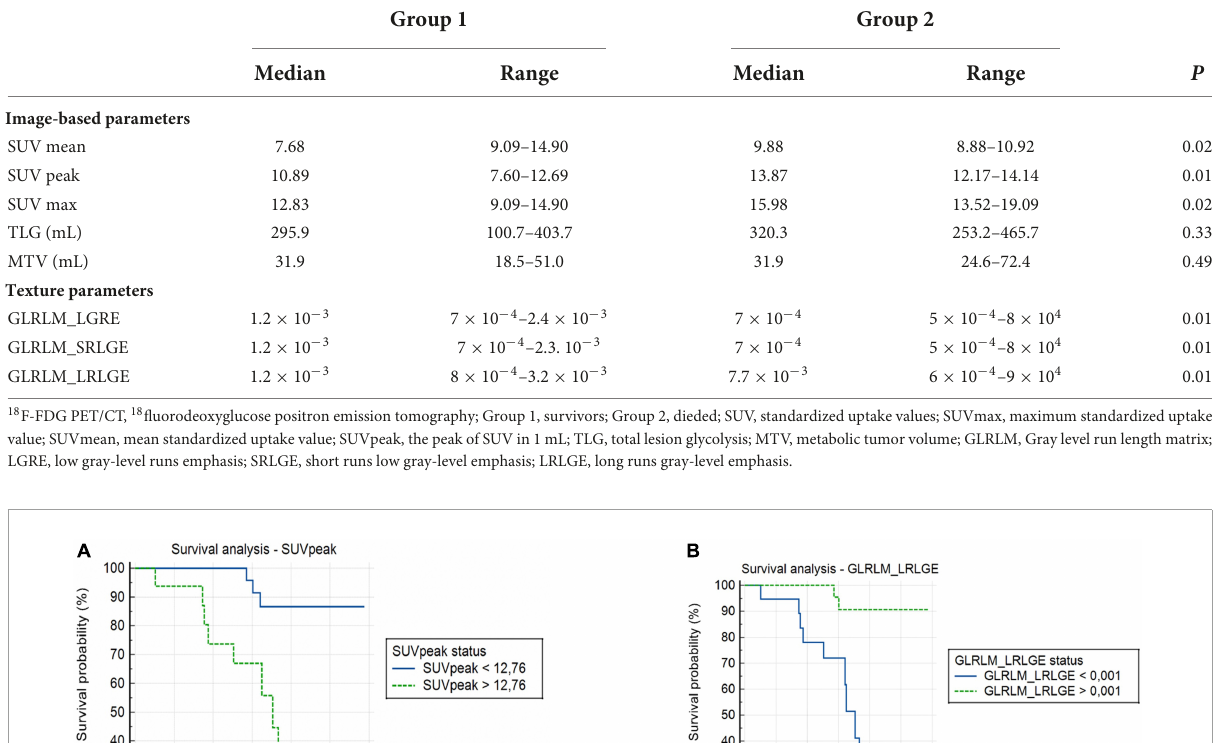
Both SUVpeak and GLRLM_LRLGE were not correlated with FIGO staging ( Supplementary Table 1